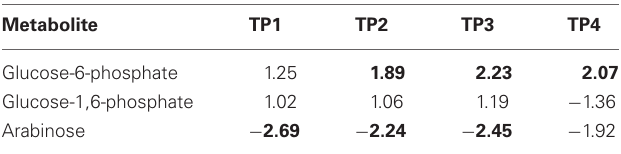
Table 1 | Changes in steady-state metabolite levels during winter